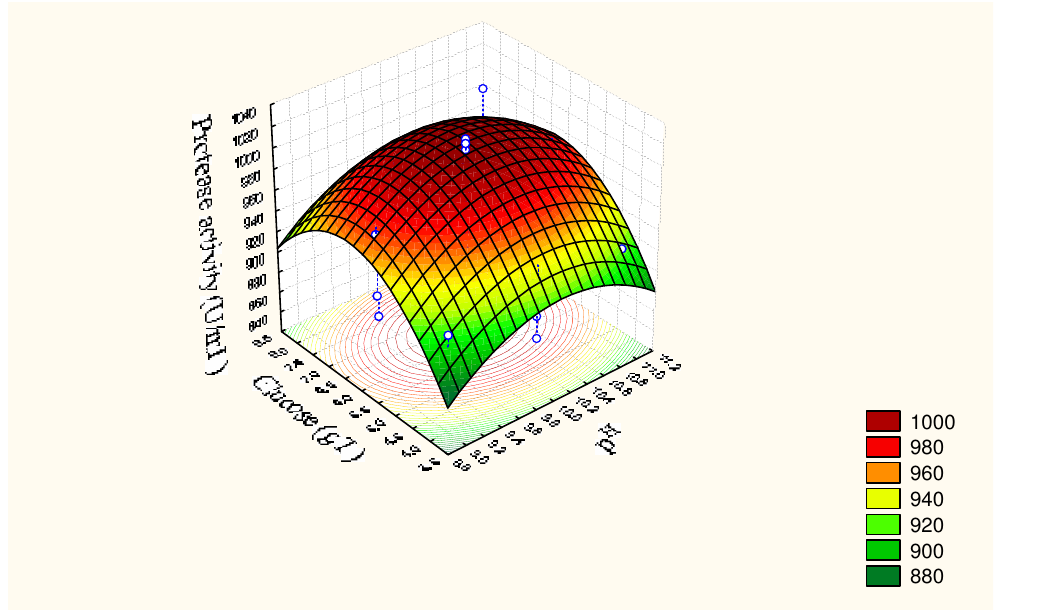
Figure 3(d). Effect of pH & glucose on protease